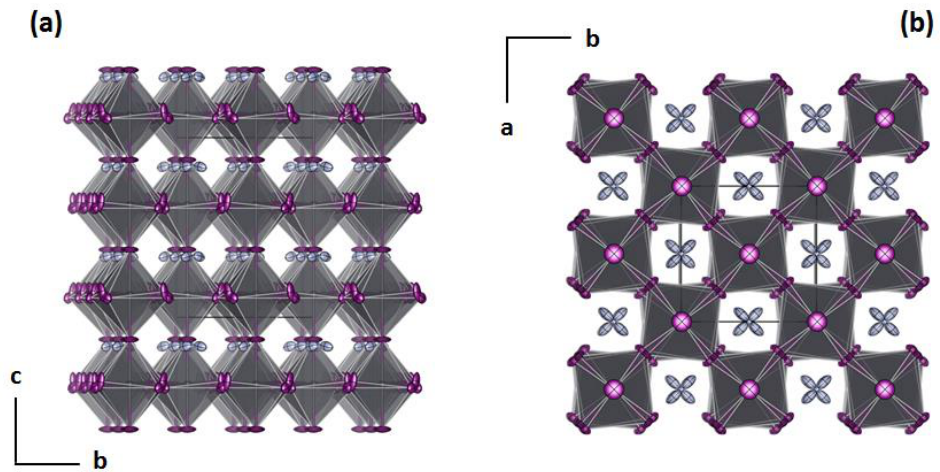
Figure 3. Projections of the MAPI “A” (synthesized in γ -butyrolactone, GBL, with acetic acid as an additive) crystal structure in the I 4 cm symmetry: down [100] in ( a ), and down [001] in ( b ). Pb, as well as I1, lies on general positions corresponding to the Wyckoff site 4 a (0,0, z ); I2 is disordered over two adjacent 8 c Wyckoff sites. The C–N disorder has been refined using EXYZ and EADP constraints. The highest residual electron density peak (+3.75 e · Å − 3 ) was observed in the vicinity of I2. The interatomic distances observed for the PbI 6 octahedron (including the distorted I2 atom) are in the range from <3.135(15)–3.201(2) Å> with a